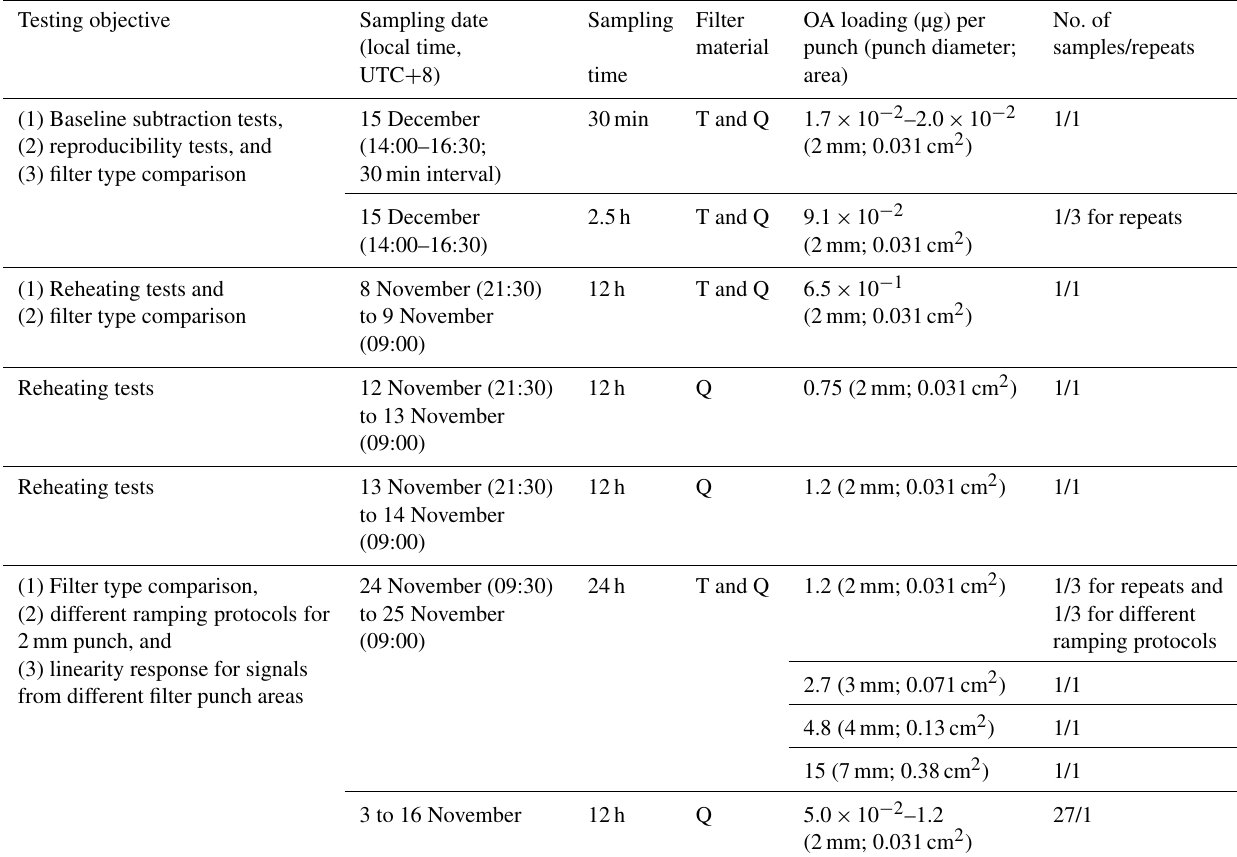
Table 1. Testing objectives, filter deposition dates and times, flows, filter material (T is for Teflon; Q is for quartz fiber), filter mass loadings of OA, number of samples, and number of sample repeats (filter punches) for the same